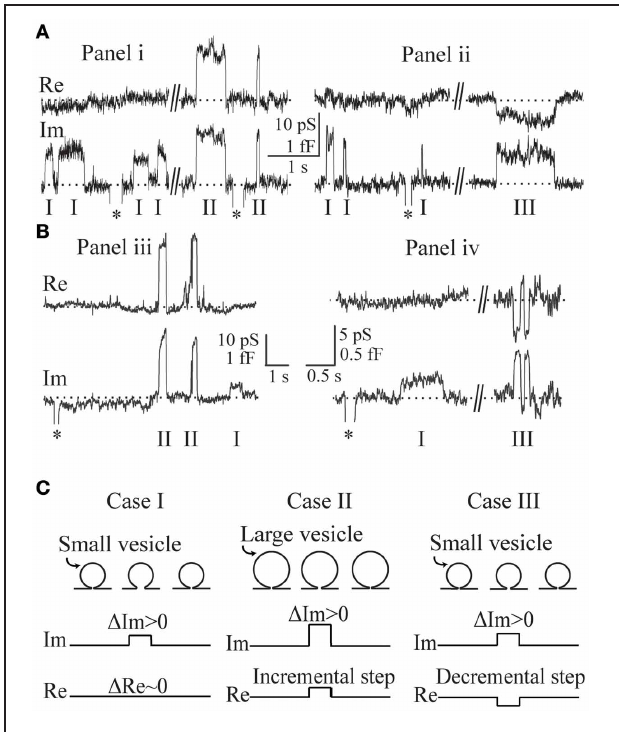
FIGURE 2 | Representative admittance measurements recorded in lactotrophs (Ai,ii) and astrocytes (Biii,iv) revealing a zero projection (case I), an incremental projection (case II), and a decremental projection (case III), on the Re part of the admittance signal. The asterisks in these recordings indicate calibration pulses. The recordings in (Ai,ii) and (Biii,iv) are recorded in the same patch of a lactotroph and an astrocyte, respectively. By incorporating the estimated (cid:2) Im and (cid:2) Re into the Equation (2), the corresponding vesicle capacitance amplitudes are determined for each event from the admittance records. For the recording in lactotrophs (Ai,ii) , the vesicle capacitance of case I, case II, and case III, is 0.9fF, 4.0fF, and 1.2fF, and for the astrocytes (Biii,iv) , it is 0.3fF, 1.6fF, and 0.6fF, respectively. Note the larger vesicle capacitance of case II when compared to case I. A schematic representation of the three cases as pre-fused vesicles with an initial narrow fusion-pore (C)